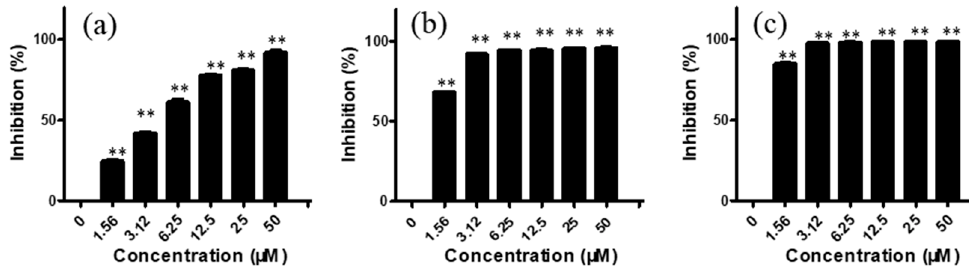
Figure 2. Effects of arnicolide D on proliferation of CNE-2 cells. CNE-2 cells were treated with different concentrations (0–50 μ M) of arnicolide D for ( A ) 24 h, ( B ) 48 h, or ( C ) 72 h, after which MTT assay was used to evaluate the anti-proliferative effects. Cells without drug treatment were used as a control. Data are shown as means ± SD. ** p < 0.01, compared with control.